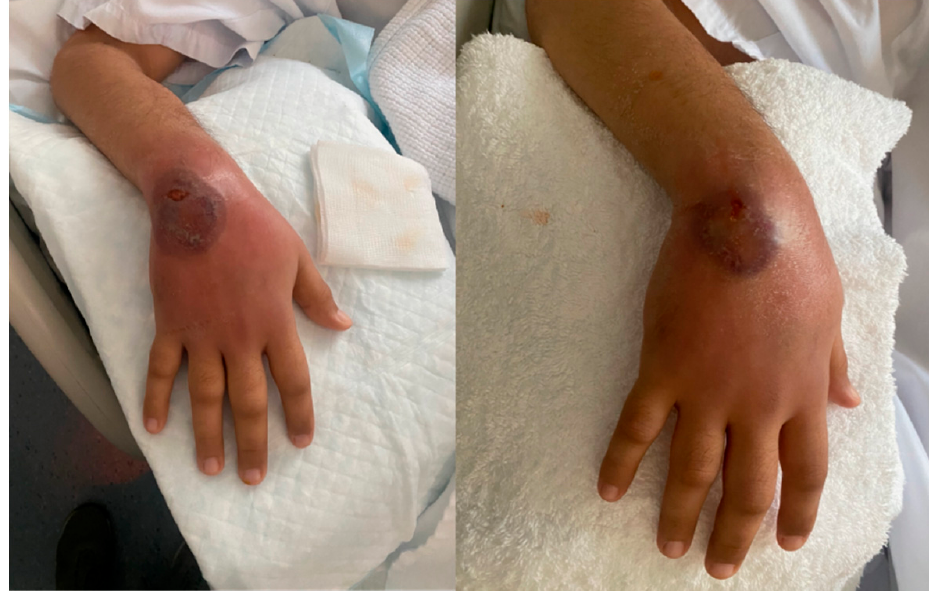
Figure 1. Right hand swelling with eschar on the dorsum that developed in hospital.